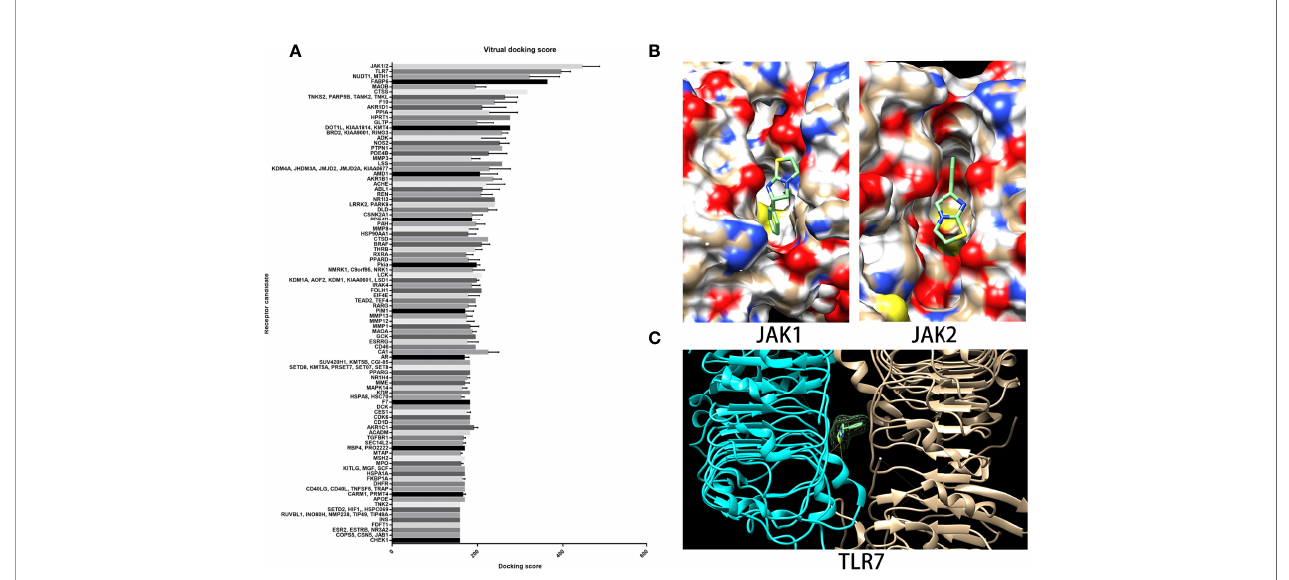
FIGURE 5 | JAK1/2 and TLR7 were predicted binding targets with relatively high binding scores via virtual docking assay. (A) The target library and docking algorithm developed by the Vslead team were employed in this study, and the target library was used to screen the potential binding targets of LMS, which ranked them according to the binding score. (B) The binding site and position of LMS on the crystal structure of JAK1 (5e1e) and JAK2 (3eyg) were analyzed via Dock6 and presented: two H-bonds were indicated. (C) The crystal structure of the TLR7 complex (6if5) was shown and the binding site of LMS to TLR7 was analyzed by